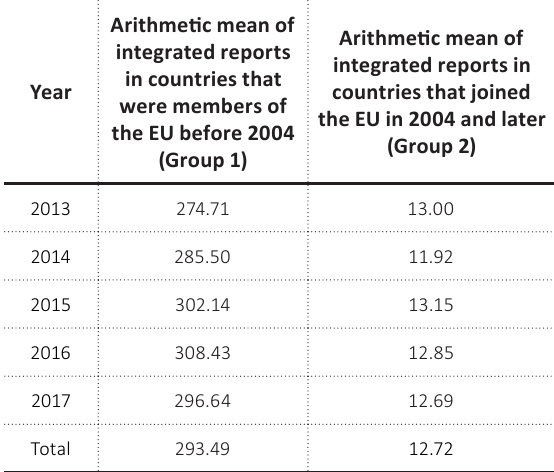
Table 8. The ratio between the number of integrated reports and real GDP per capita in individual EU countries